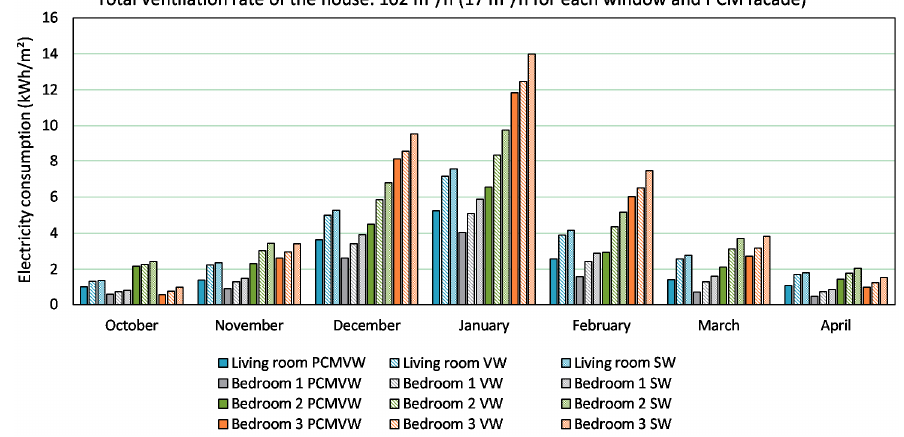
( b ) Figure 17. Winter reference case 1 using stand-alone ventilated windows (VW) [14]. ( a ) Bypass ventilation , when T indoor > 24 °C. ( b ) Heat mode, when T indoor < 24 °C .